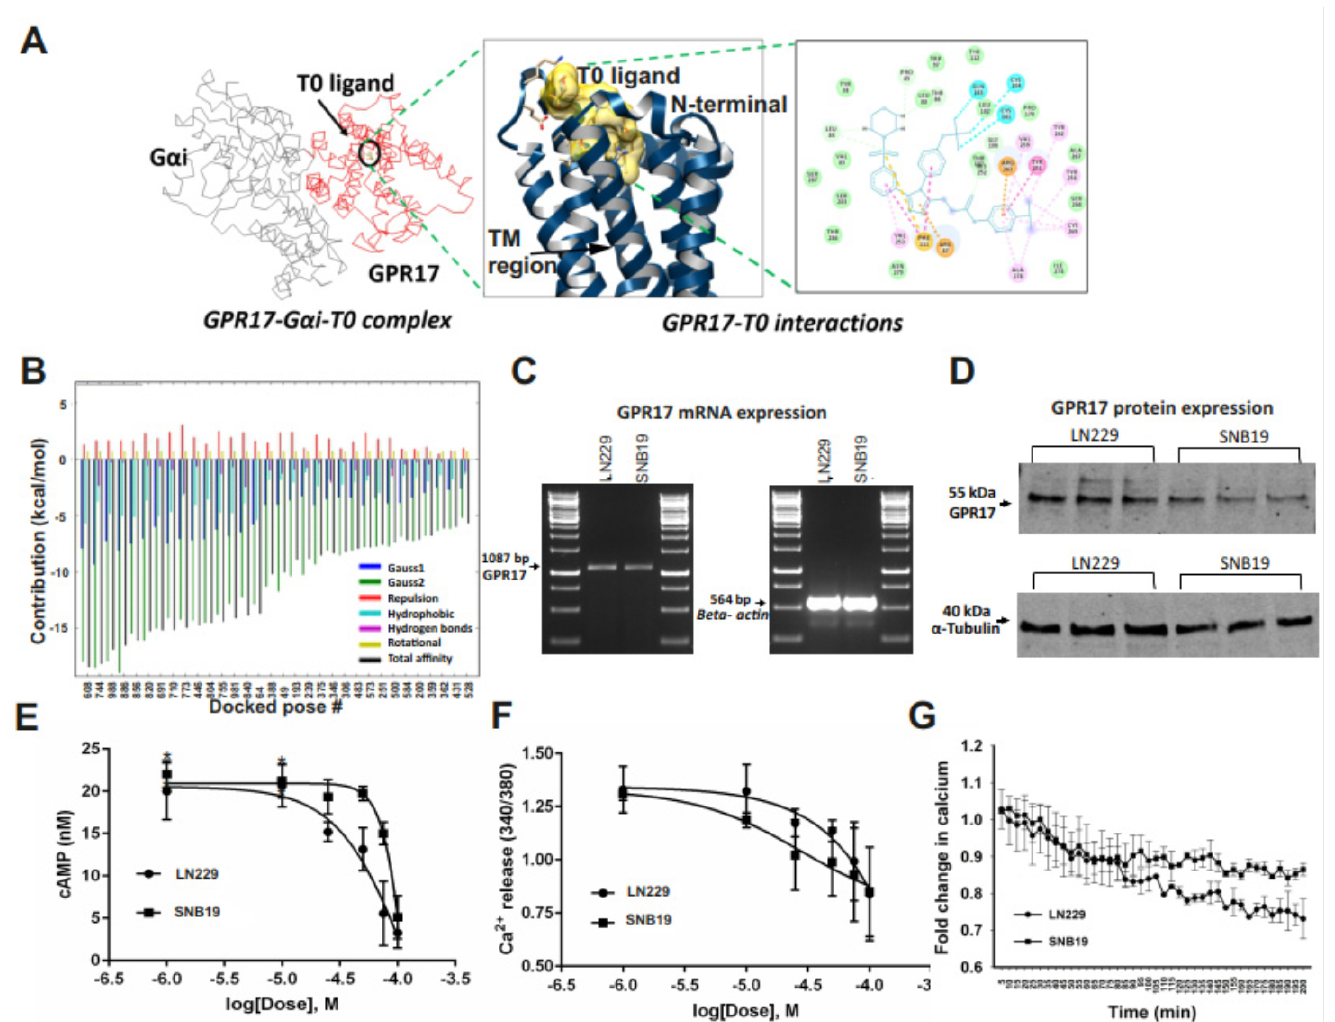
Figure 2. GA–T0 as a potential GPR17 agonist in GBM cells. ( A ) GPR17–G α I complex obtained from the protein–protein docking where GPR17 is colored red, G α I is grey, and the GA-T0 complex in the black circle. The portion of GPR17–GA-T0 is magnified in the 2-dimensional and 3-dimensional interaction figure. ( B ) Docked structure of the GPR17–G α I–GA-T0 complex ranked according to binding energy from different interactions, including hydrogen bonds, hydrophobic interaction, ion pair interaction, aromatic interaction, and cation pi interaction. ( C ) RT-PCR analysis of the GPR17 receptor expression in LN229 and SNB19 cells, using β -actin as a constitutive control. ( D ) Immunoblot analysis of GPR17 suppressing cell proliferation in LN229 and SNB19 cells with α -tubulin as the loading control. ( E ) cAMP level (nM) and ( F ) ratiometric (340/380 nm) analysis of Ca2+ release in the SNB19 and LN229 cell lines on treatment with GA-T0. ( G ) Fold change in the Ca 2+ level over the time (min) in GBM cells. Data are representative of at least three independent experiments ( n = 6) using t-test analysis. ( E–G ) The results are presented as the mean values ± SEM of six experiments. Significant data are denoted by asterisks (*, p <